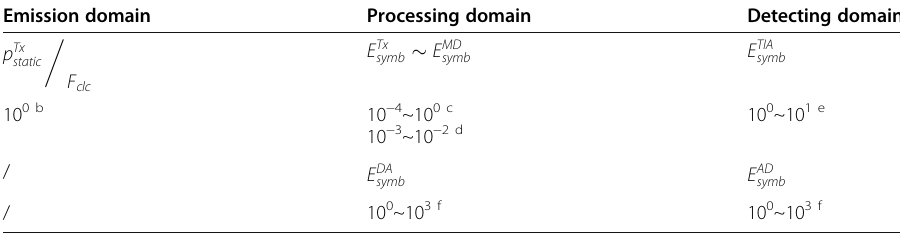
Table 2 Typical value of energy consumption per symbol operating in each device of OPU a Emission domain Processing